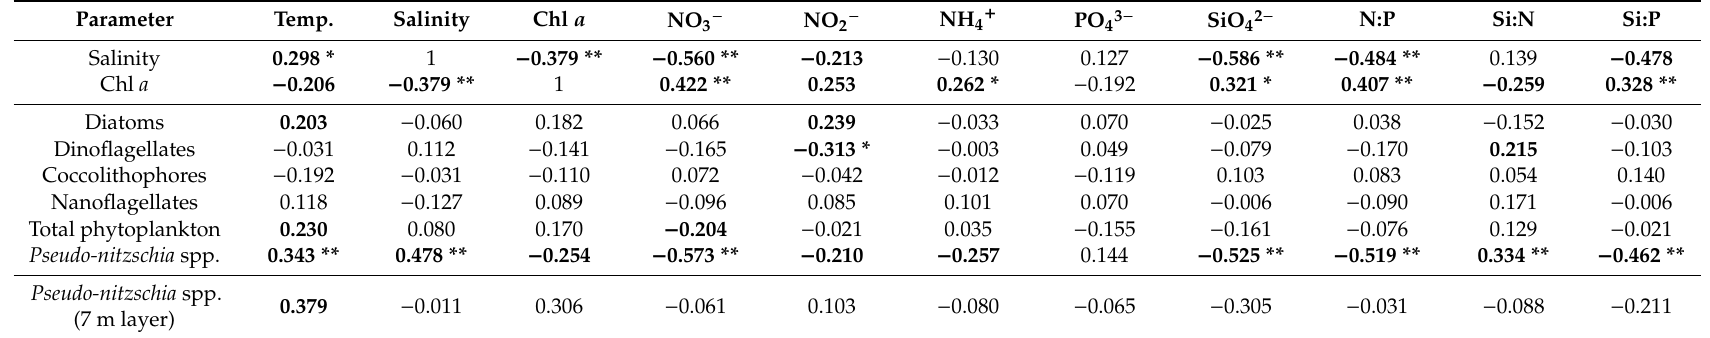
Table 2. Spearman rank correlation coe ffi cients between environmental parameters and phytoplankton groups and the abundance of Pseudo-nitzschia spp. ( n = 98–102). Statistically significant results ( p < 0.05) are marked in bold, * p < 0.01; ** p < 0.001. Parameter